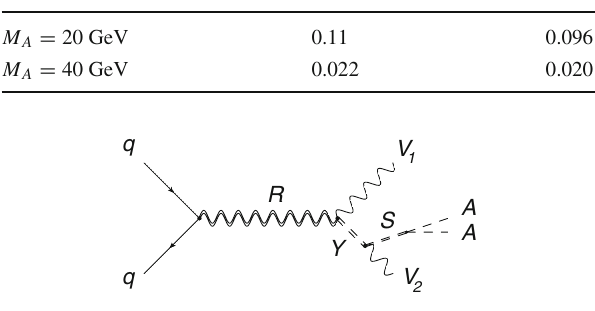
Fig. 11 Sample diagram for a R → V 1 Y → V 1 V 2 S